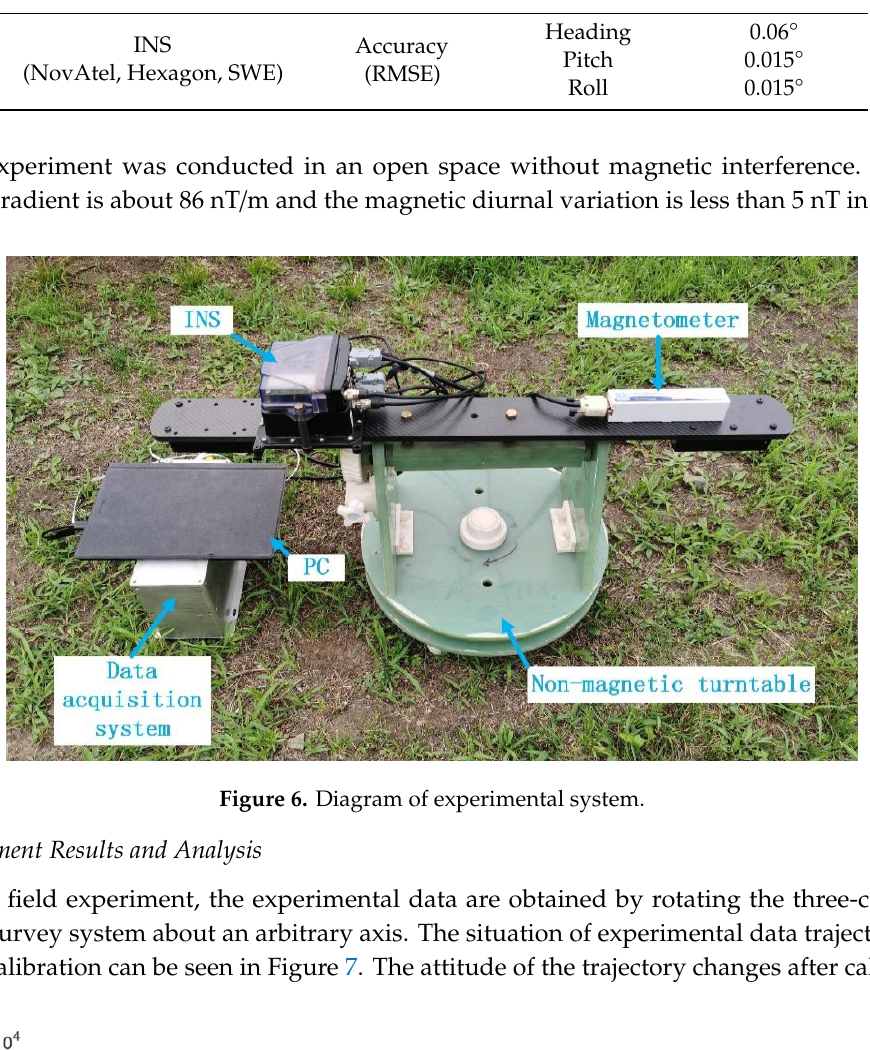
Figure 7. Trajectory coincidence after calibration.